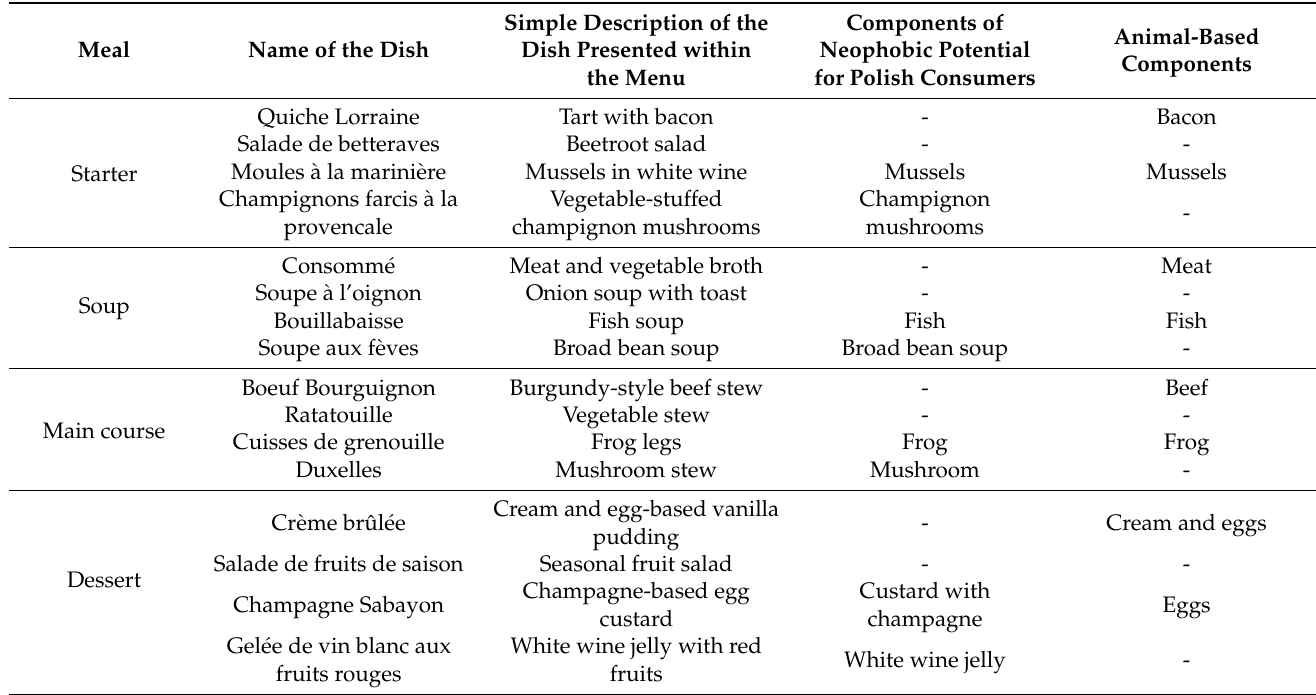
Table 1. The dishes included in the model French restaurant menu developed for the study, within a 2 × 2 factorial design for components of neophobic potential and animal-based